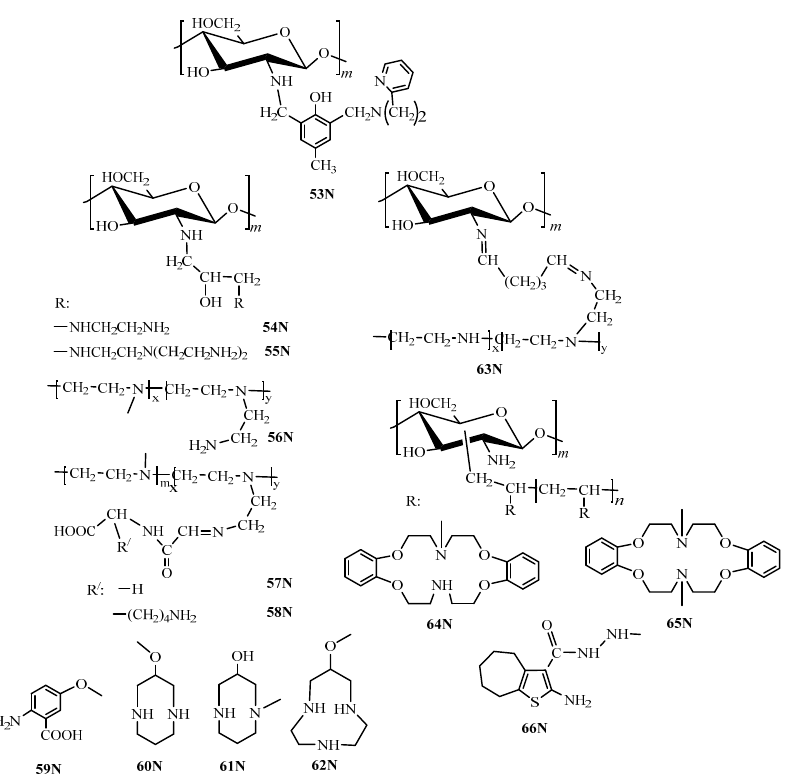
Figure 7. Structure of N -containing derivatives of chitosan with linker: 53N —chitosan functionalized with 2[-bis-(pyridylmethyl)aminomethyl]-4-methyl-6-formylphenol; 54N –ethylenediamine modified magnetic crosslinking chitosan; 55N —chitosan-based resins modified with tris(2-aminoethyl)amine moiety; 56N —polyaminated chitosan chelating resin; 57N —glycine modified crosslinked chitosan resin; 58N — L -lysine modified crosslinked chitosan; 59N —chitosan resin functionalized with 2-amino-5- hydroxybenzoic acid; 60N —1,5-diazacyclooctane chitosan; 61N —3-hydroxy-1,5-diazacyclooctane chitosan; 62N —3-hydroxy-1,5,8-triazacyclodecyl chitosan; 63N —polyethyleneimine-grafted chitosan; crown ether crosslinked chitosan; 66N —chitosan- grafted-poly(2-amino-4,5-pentamethylenethiophene-3 -carboxylic acid N -acryloyl-hydrazide) chelating